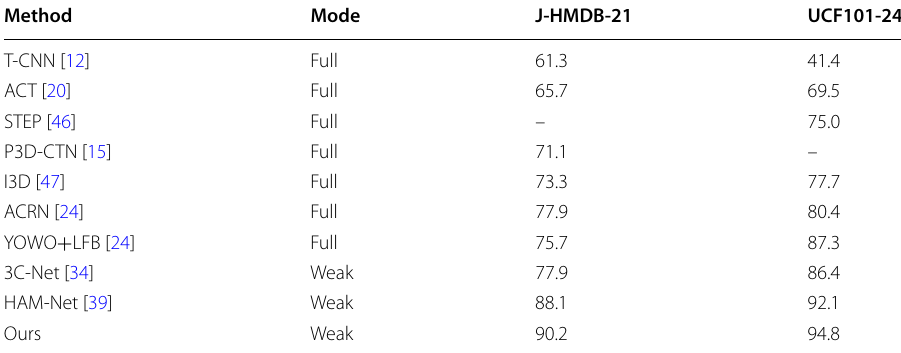
The table lists the comparison results of Frame-mAP (IOU 0.5, 16 frames clip). We compared with recent fully and weakly = supervised methods. Note that, the proposed method is an object location-unsupervised classification-supervised attention